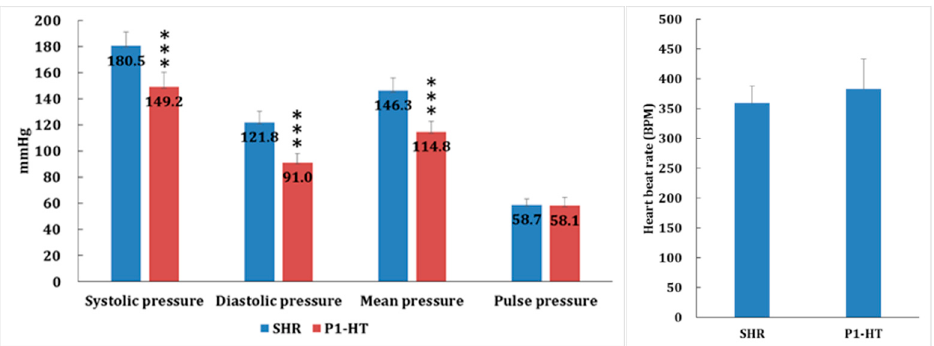
Figure 1. Blood pressure value comparisons of two spontaneous hypertensive rat (SHR) models: SHR rat ( n = 5) and the new breeding P1-HT rat ( n = 15). In the adult P1-HT rat (age 8 weeks) the systolic pressure is 149 ± 11 mmHg, diastolic pressure is 91 ± 7 mmHg, mean arterial pressure is 115 ± 8 mmHg, pulse pressure is 58 ± 6 mmHg, and heart beat rate is 380 ± 50 BPM. The blood pressure status of this new breed P1-HT rat could endure the tendency of clinical phase I hypertension for more than one year (*** p < 0.001).